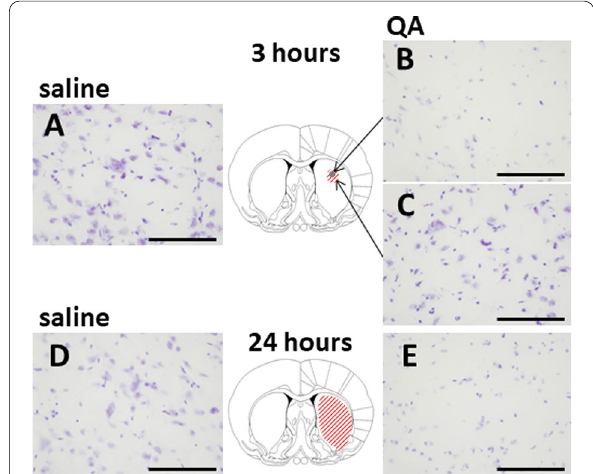
Fig. 5 Nissl-stained brain slices within the striatum after the acquisition of ex vivo fluorescent images. QA was injected into the striatum, and saline was simultaneously injected into the contralateral striatum. Three hours ( A – C ) or 24 h ( D and E ) after QA or saline injection. Neuronal degradation was observed in the greyed-out area within an approximately 1.0-mm-diameter area ( B ) and in the whole striatum ( E ). The red hatched area corresponds to the area of increased fluorescence signal. The images in A, C, and D showed no abnormalities. Bar 100 = injection, using monoclonal antibodies against NeuN, a marker for neurons (Fig. 6A–F), and CD11b, a marker for activated microglia (Fig. 6G–L). In the QA-injected striatum, the quantity of NeuN-positive cells was reduced to 60 9% (Fig. 6E, 505 122 cells/mm 2 , n 4, ± ± = p < 0.01) compared with that in the saline-injected stri- atum (Fig. 6B, 827 122 cells/mm 2 , n 4), and CD11b- ± = positive cells were increased to 591 165% (Fig. 6 K, ± 531 38 cells/mm 2 , n 4, p < 0.001) compared with ± = those in the saline-injected striatum (Fig. 6H, 96 22 ± cells/mm 2 , n 4). Furthermore, as shown in Fig. 6L, the = majority of DHE fluorescence signals colocalised with CD11b-positive cells in the QA-injected striatum.